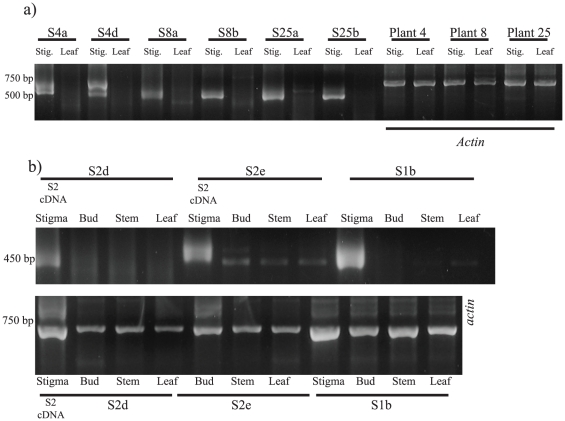
RT-PCR of putative S-locus genes from stigmatic, stem and leaf tissues using allele-specific forward primers and a universal amplification reverse primer.(a) Expression of A. munita sequences was detected in stigmatic but not leaf tissue. (b) Expression in P. californicus tissues is highest in stigmas as expected for S-alleles. Actin primers were used as positive controls for all plant tissue cDNA from both species. Putative alleles S2d and S2e appear to be linked. Sequencing of bands in non-stigmatic tissue using S2e primers showed that they are products not previously identified from stigmas. Actin primers were used only once on plant S2 stigmatic tissue, hence there is one less lane in the actin gel than in the allele specific gel.